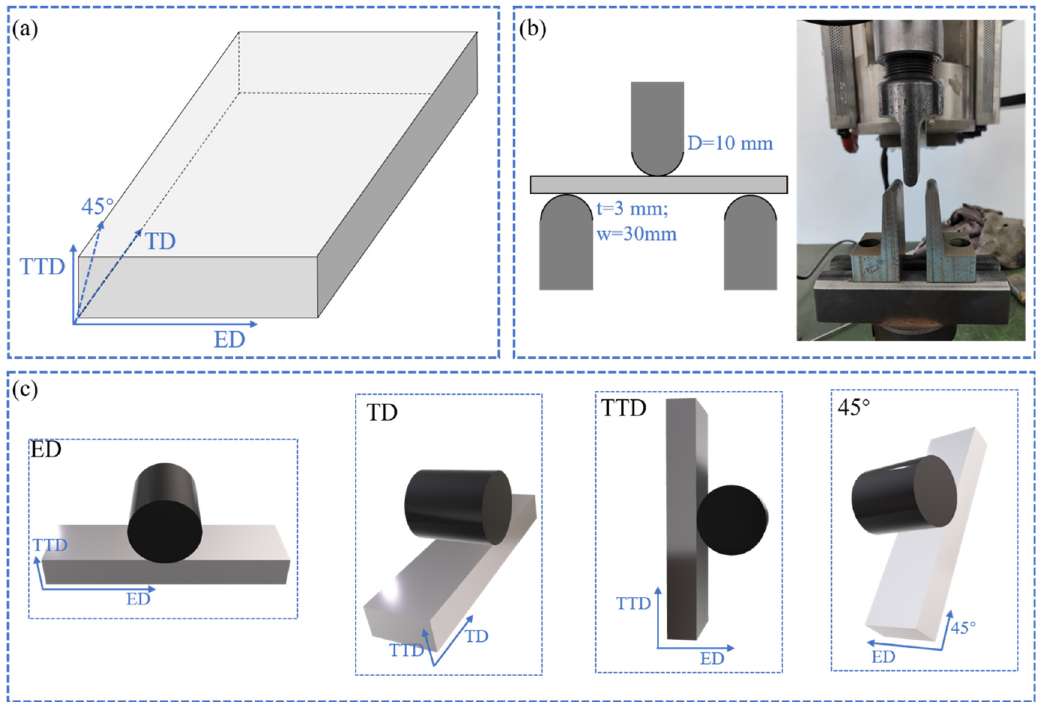
Figure 1. Diagram for sampling and bending test of the Mg–9Al extrusion plate: ( a ) sampling coordinate system; ( b ) schematic illustration and physical setup of the three-bending test; ( c ) coordinate system for the three-point bending test.